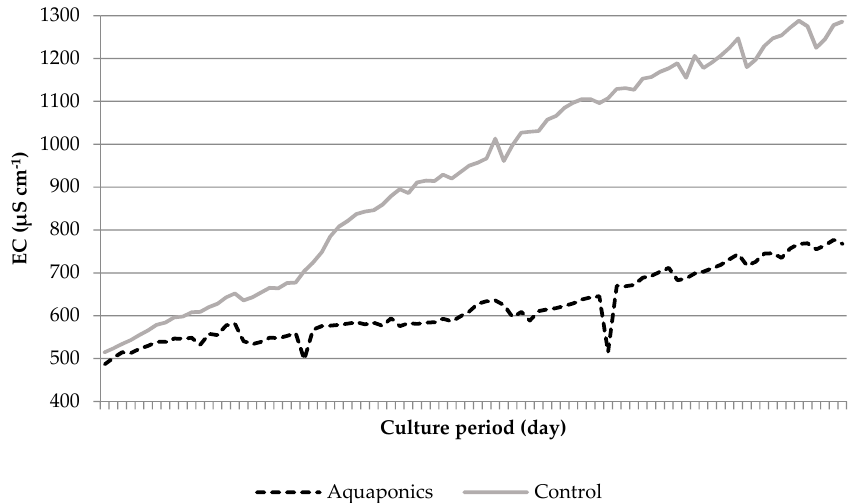
Figure 10. Temporal changes of the pH-value over the experimental period of 12 weeks.